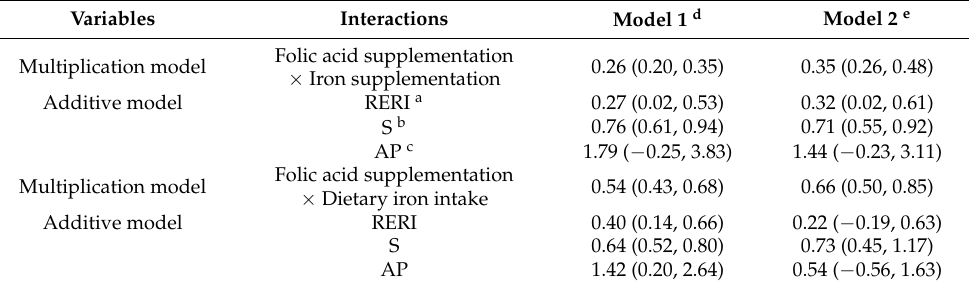
Table 4. Multiplicative and additive interaction of maternal folic acid and iron nutrition in incidence of